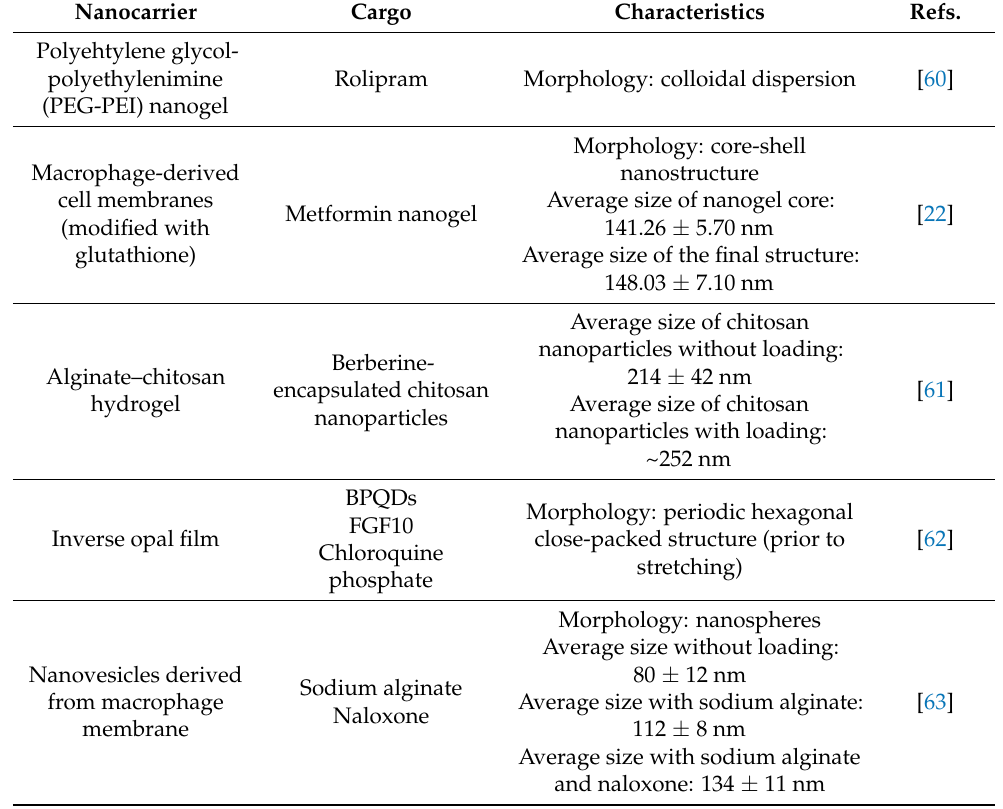
Table 5. Examples of other types of nanosystems for spinal cord